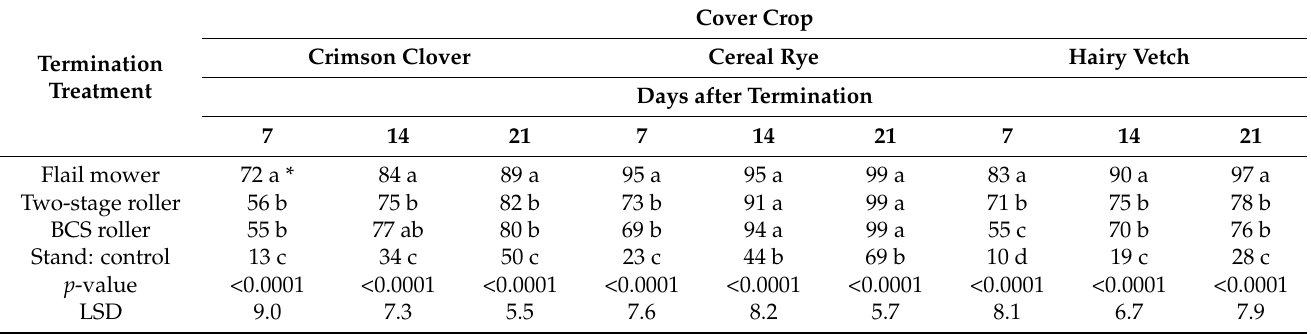
Table 5. Termination rates (%) averaged over three growing seasons for three cover crops and weeks of